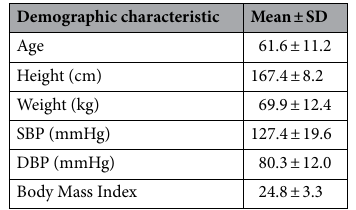
Table 3. Demographic characteristic of patients.